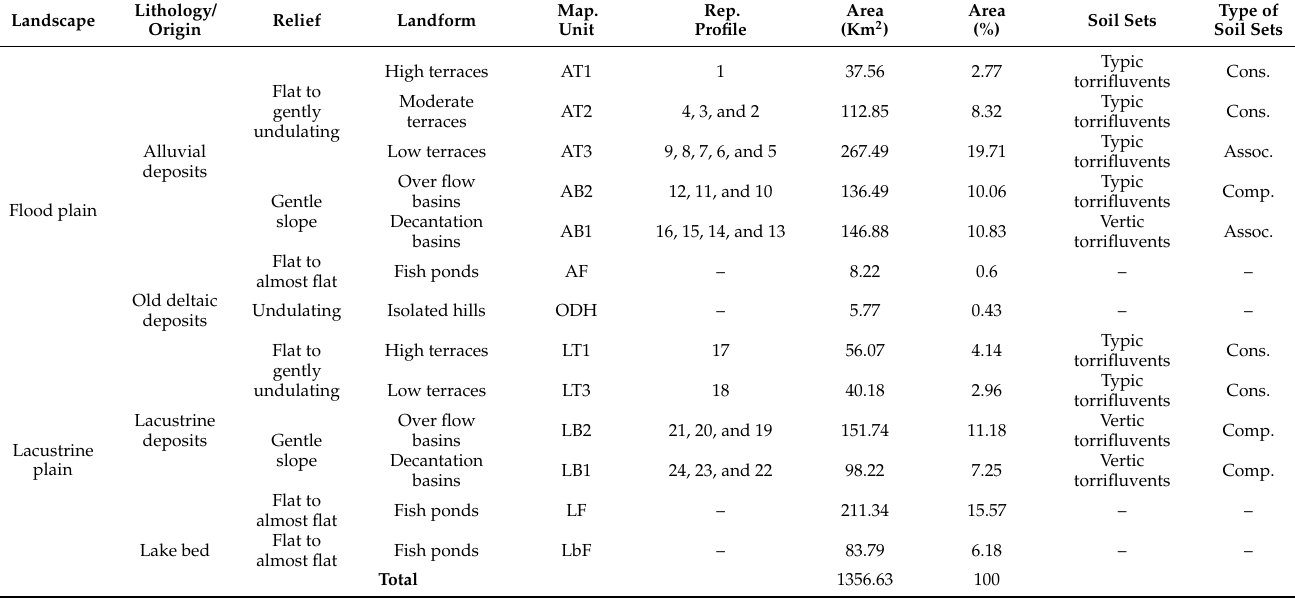
Table 1. Physiographic and soil map legends of the investigated